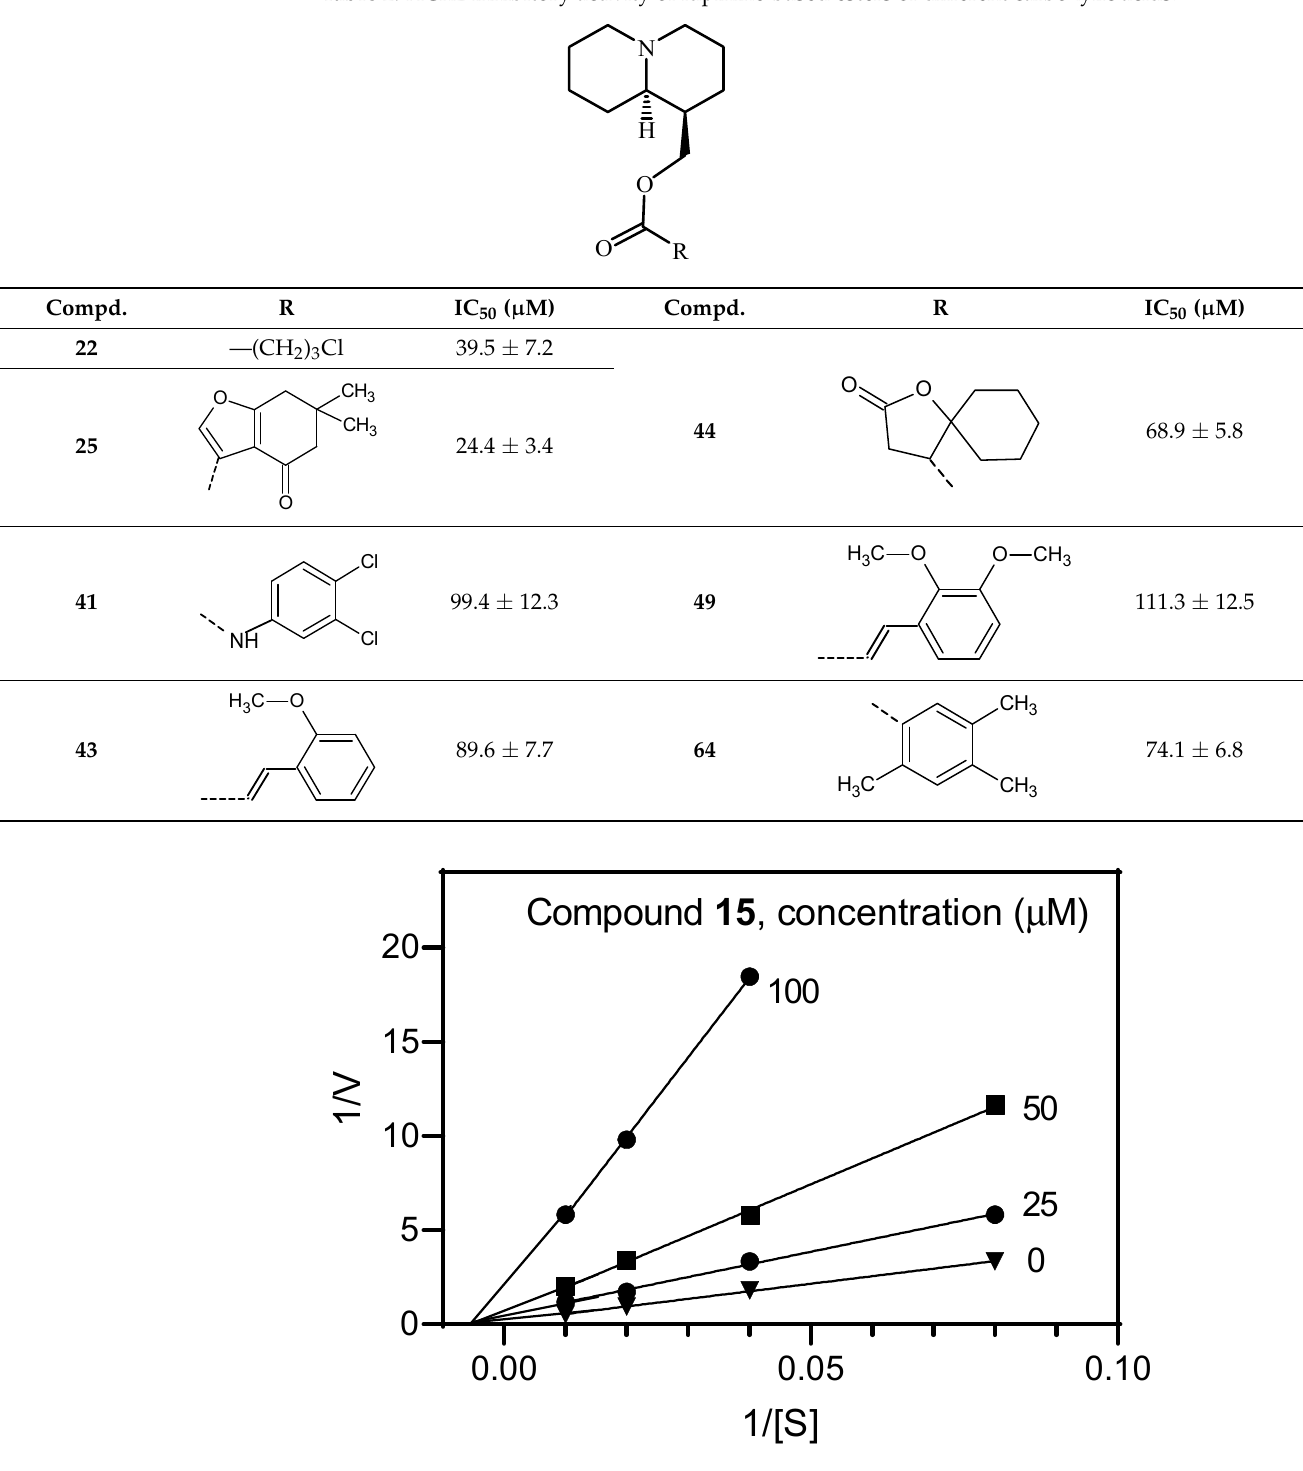
Figure 1. Representative double-reciprocal Lineweaver–Burk plot illustrating the mixed-type mecha- nism of AChE inhibition by compound 15 . Table 3. Chemical structures and AChE inhibitory activities of lupinine derivative 15 and previ-